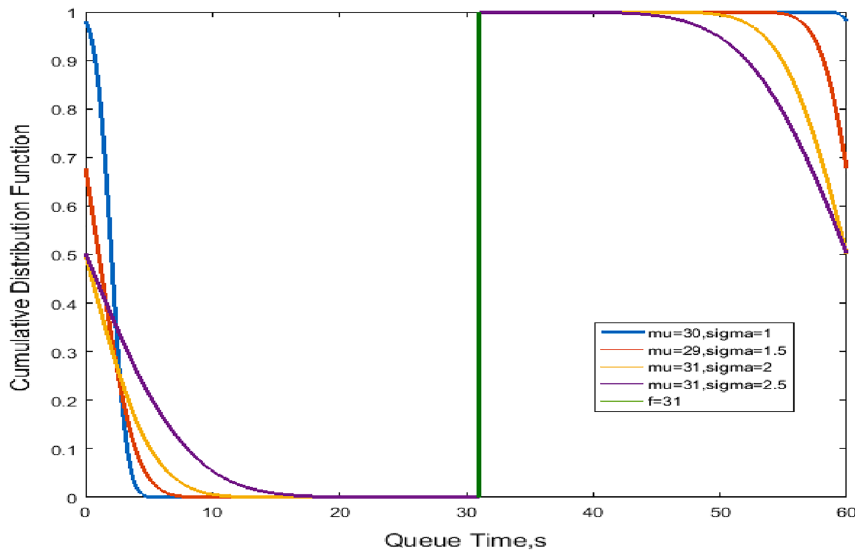
Figure 4. Cumulative probability of queue time.